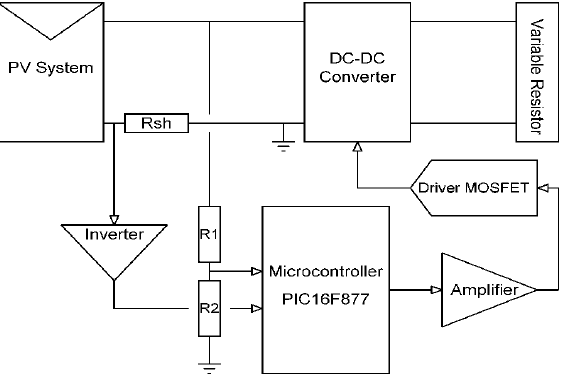
Figure 2. Block diagram of the digital power point tracking (MPPT) control.